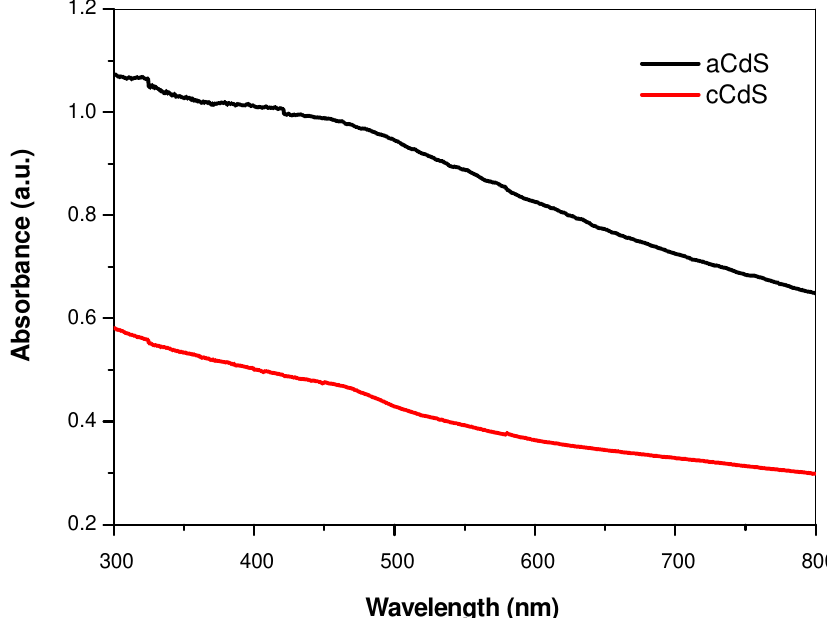
Figure 4. UV-Vis absorption spectra of aCdS and cCdS samples.